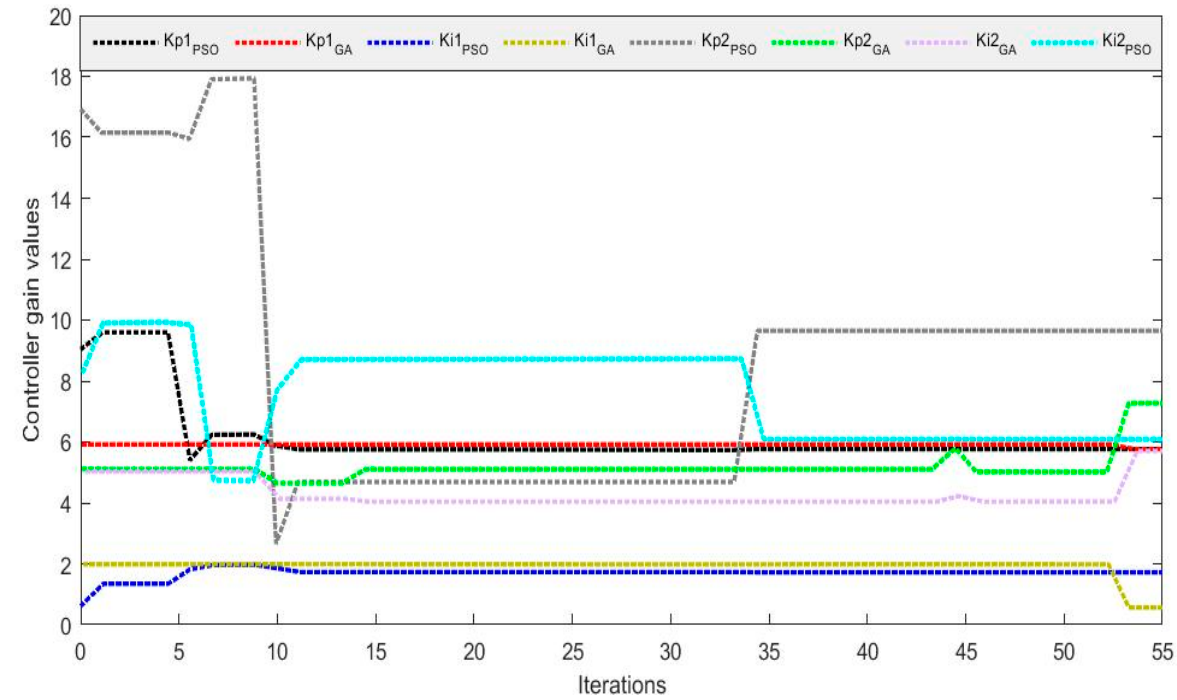
Figure 24. Best controller position for PSO and GA algorithm.